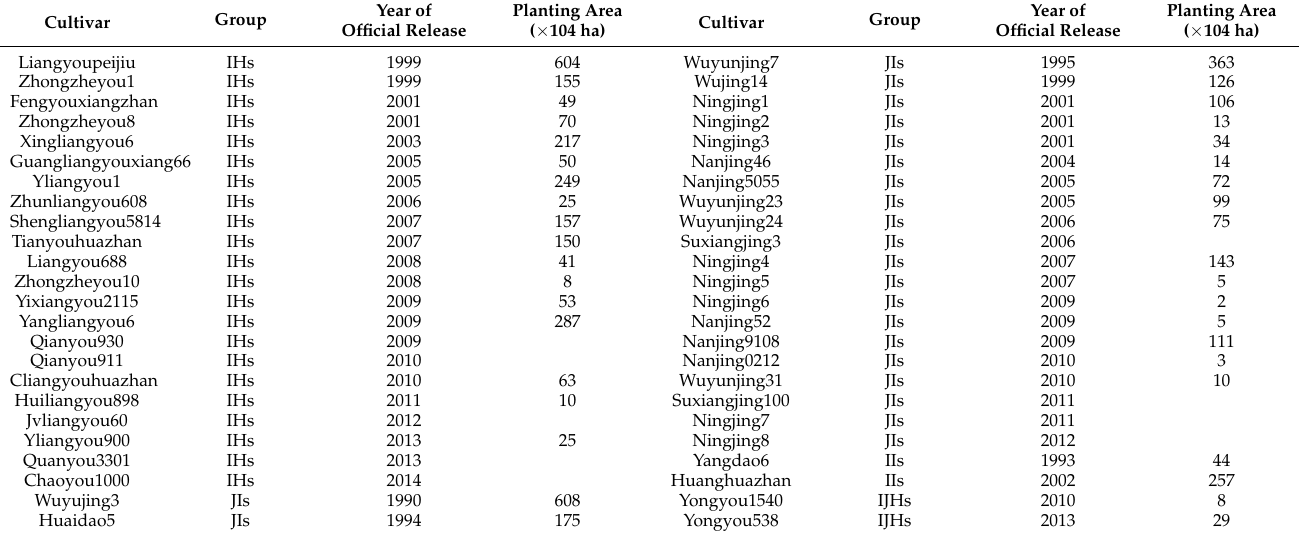
Table 1. Different rice cultivars tested in this study in 2017 and 2018.